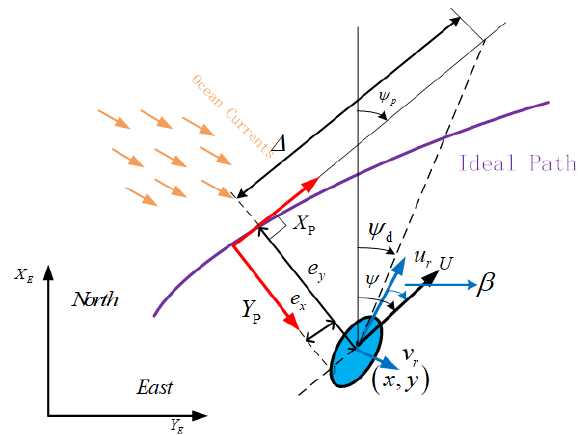
Figure 1. Geometric information of the path